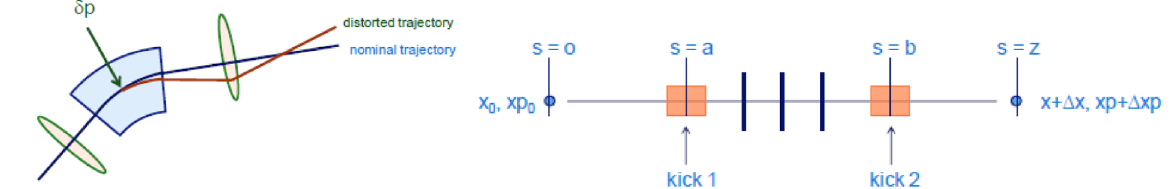
FIG. 3. Schematic of CSR kick model. Left: particle ’ s trajectory is distorted by the local change of longitudinal momentum in a dispersive region, due to CSR emission. Right: double-bend achromatic cell used for comparison of E LEGANT result and analytical prediction of CSR-induced emittance growth, see Table II.